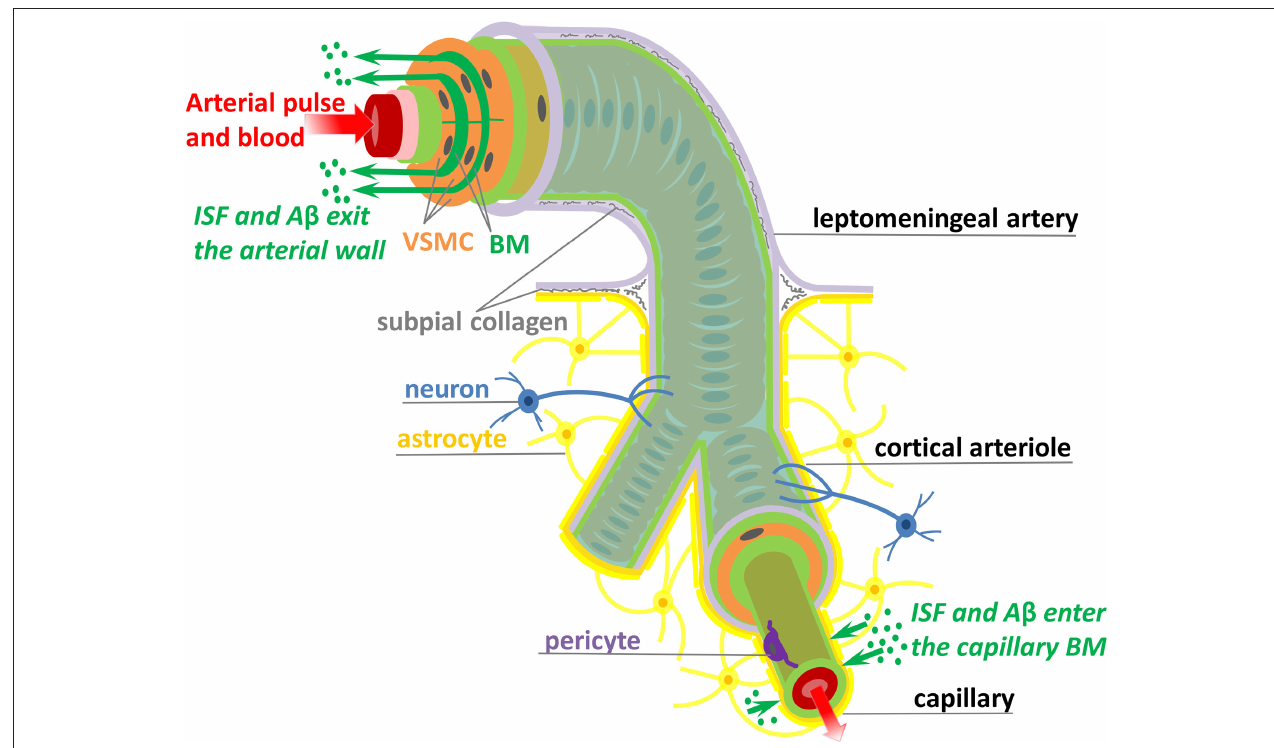
FIGURE 1 | Schematic representation (not to scale) of the IPAD pathways. Soluble A β (green dots) and ISF from the brain interstitium enter the BM of capillaries and flow upstream toward large arteries through the BM (dark green) positioned between VSMCs (orange). Transport along the IPAD pathways is shown by the green arrows which are against the direction of arterial pulse and blood flow (red arrow). Three concentric layers of VSMCs are pictured at the larger extreme of the artery, while, for the sake of simplicity, only the outer most layer of VSMCs is shown along the length of the artery. The artery is wrapped in a pial sheath (light purple) and innervated by neurons (blue). At the capillary level, the endothelial BM (light green) is fused with the BM of glia limitans (dark yellow) secreted by astrocytes (yellow); they also interact with brain interstitium (due to gap junctions between the end-feet of astrocytes), allowing entrance of ISF and A β in the vascular wall ( Morris et al., 2016; Weller et al., 2018). VSMC, vascular smooth muscle cell; BM, basement membrane; endothelium (red), internal elastic lamina (pink), inner and outer BM (light green), pericyte (purple), and subpial collagen